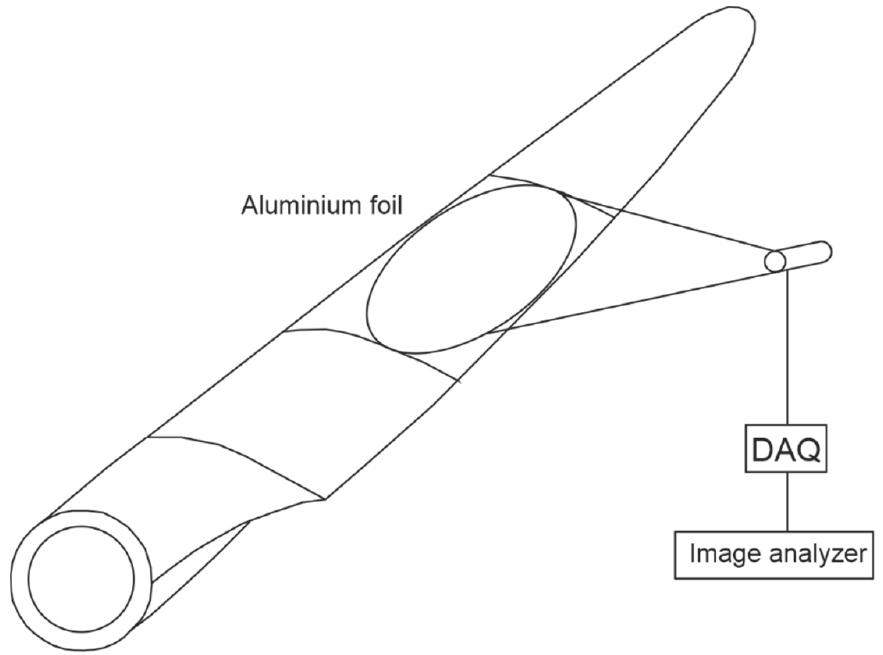
Figure 3. Infrared ice sensing technique setup [12,47].